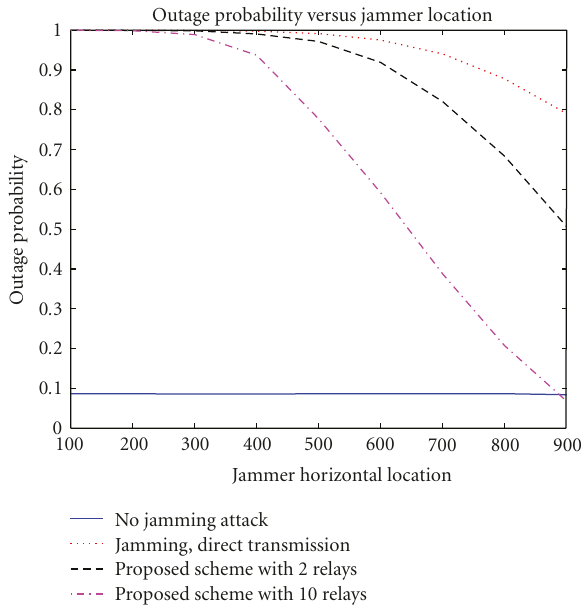
Figure 9: Outage probability versus jammer’s